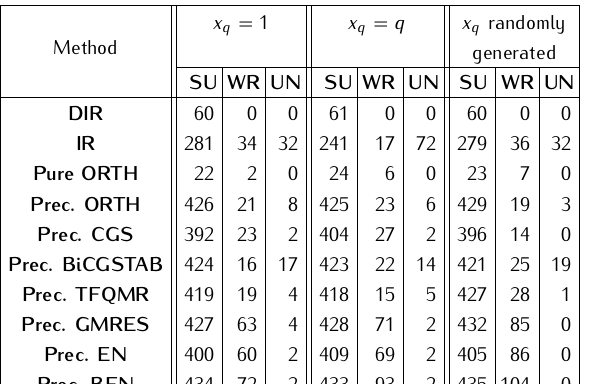
Table 10. As Table 6 (i.e. ACCUR = 10 − 10 ), but relative residual norms, introduced by (10) , are used in the stopping